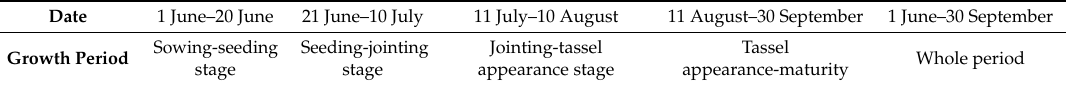
Table 1. Main growth period and date of summer maize in the Huaihe River Basin